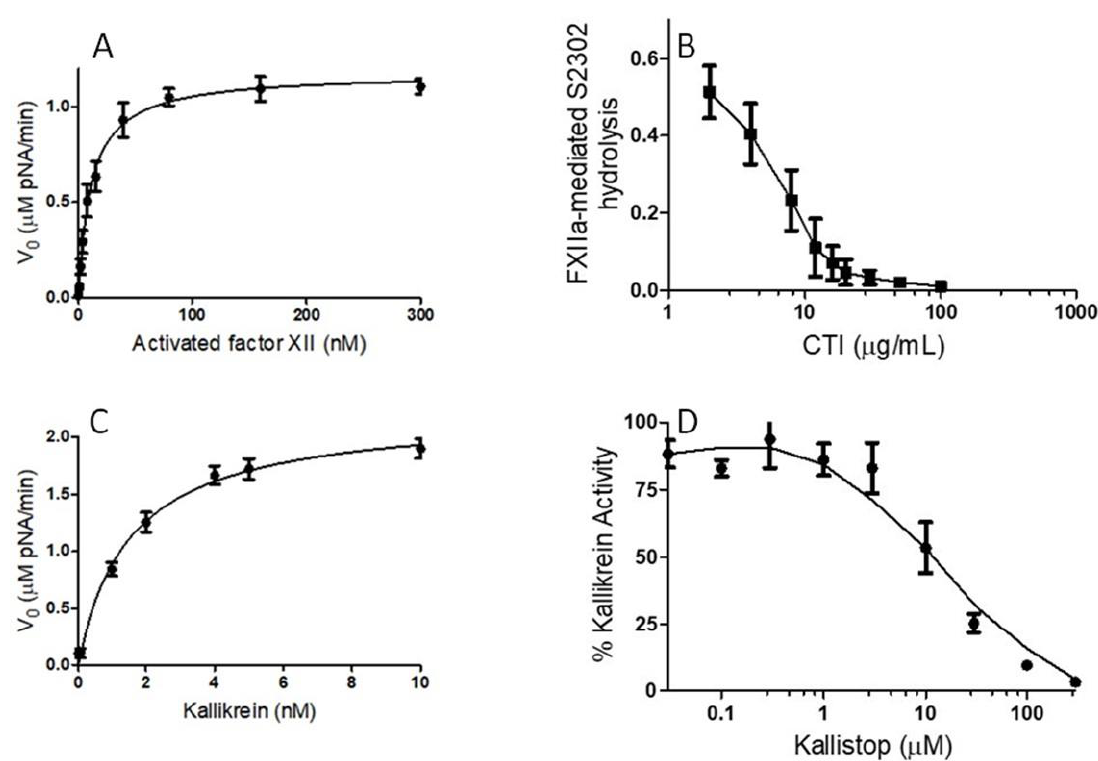
Figure 2. Characterization of human blood coagulation activated FXII (FXIIa) and kallikrein. ( A ) Chromogenic substrate assay for FXIIa activity. Varying concentrations of FXIIa (1–300 nM) were incubated with S2302 (0.5 mM). FXIIa activity was measured by monitoring the rate of S2302 hydrolysis. Changes in OD 405 nm/minute were measured on a plate reader and converted to pNA generated per minute. ( B ) Effect of corn trypsin inhibitor on FXIIa. FXIIa incubated in the absence or presence of increasing concentrations of corn trypsin inhibitor (1–100 µ g/mL). ( C ) Chromogenic substrate assay for kallikrein activity. Varying concentrations of kallikrein (1–10 nM) were incubated with S2302 (0.5 mM). Kallikrein activity was measured by monitoring the rate of S2302 hydrolysis. ( D ) Effect of kallistop on kallikrein. Kallikrein incubated in the absence or presence of increasing concentrations of kallistop (0.05–300 µ M). Data are the means of three separate